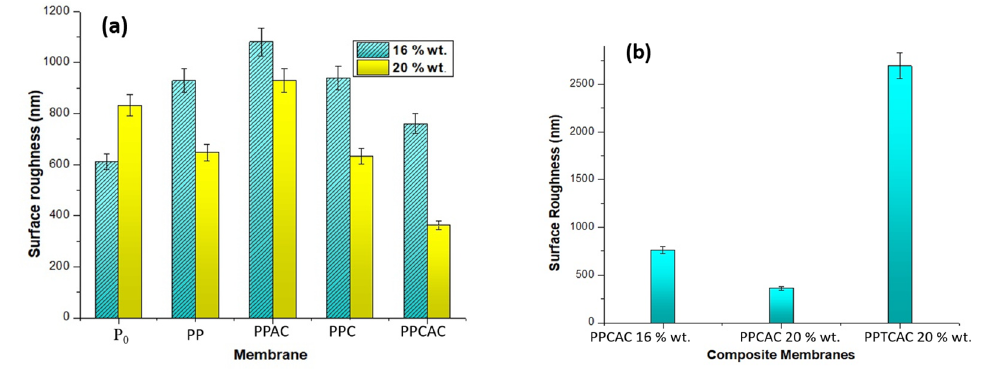
Figure 6. Surface roughness bar graph for ( a ) 16 and 20% PES membranes, and ( b ) composite mem-